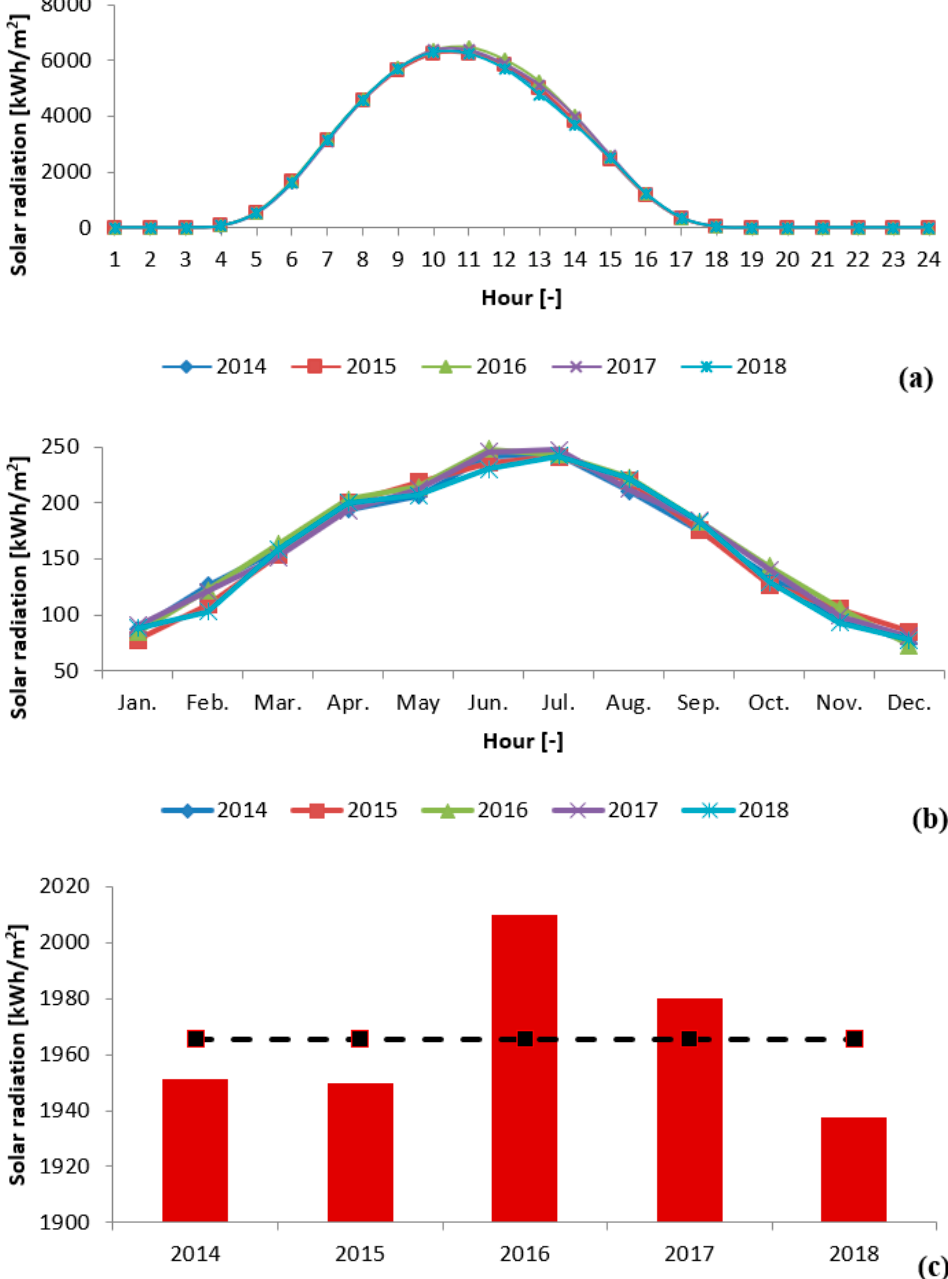
Figure 4. Global solar radiation; ( a ) Hourly, ( b ) monthly, and ( c ) annual for a period of 2014–2018.